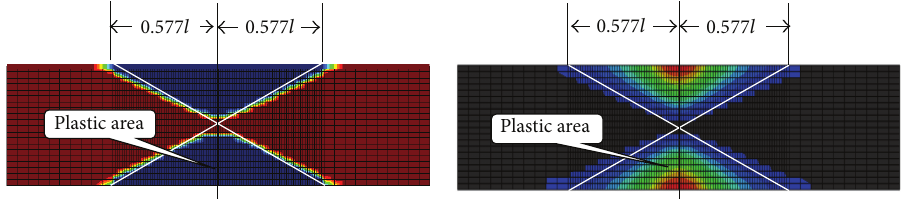
Figure 6: Plastic area under static load ( 𝑀 𝑝 = 1.5𝑀 𝑒 ).